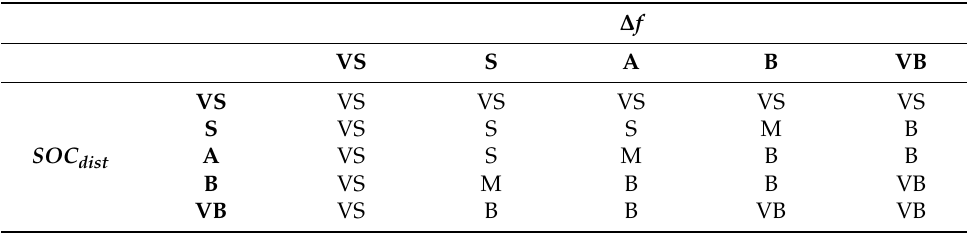
Table 1. Fuzzy rules for power change factor